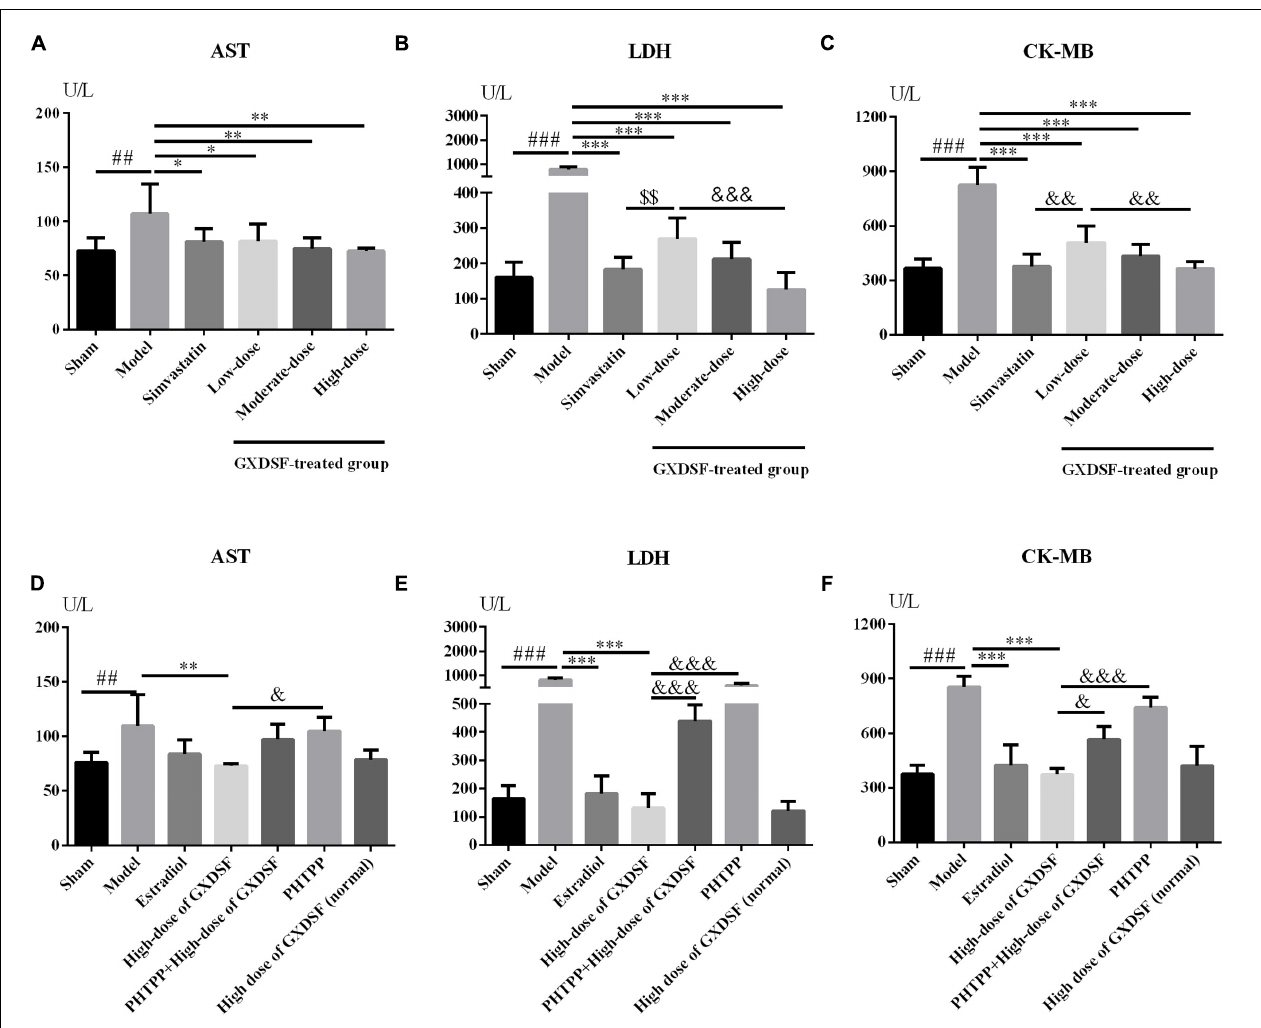
FIGURE 5 | Biochemical parameters, including AST (A,D) , LDH (B,E) and CK-MB (C,F) , in MIRI-LVR rats treated with different doses of GXDSF and PHTPP. Compared with the sham group: ## P < 0.01, ### P < 0.001. Compared with the MIRI-LVR model group: ∗ P < 0.05, ∗∗ P < 0.01, ∗∗∗ P < 0.001. Compared with the simvastatin group: $$ P < 0.01. Compared with the high-dose group: & P < 0.05, && P < 0.01, &&& P < 0.001. The data are presented as the mean ± SD ( n = 10 in each